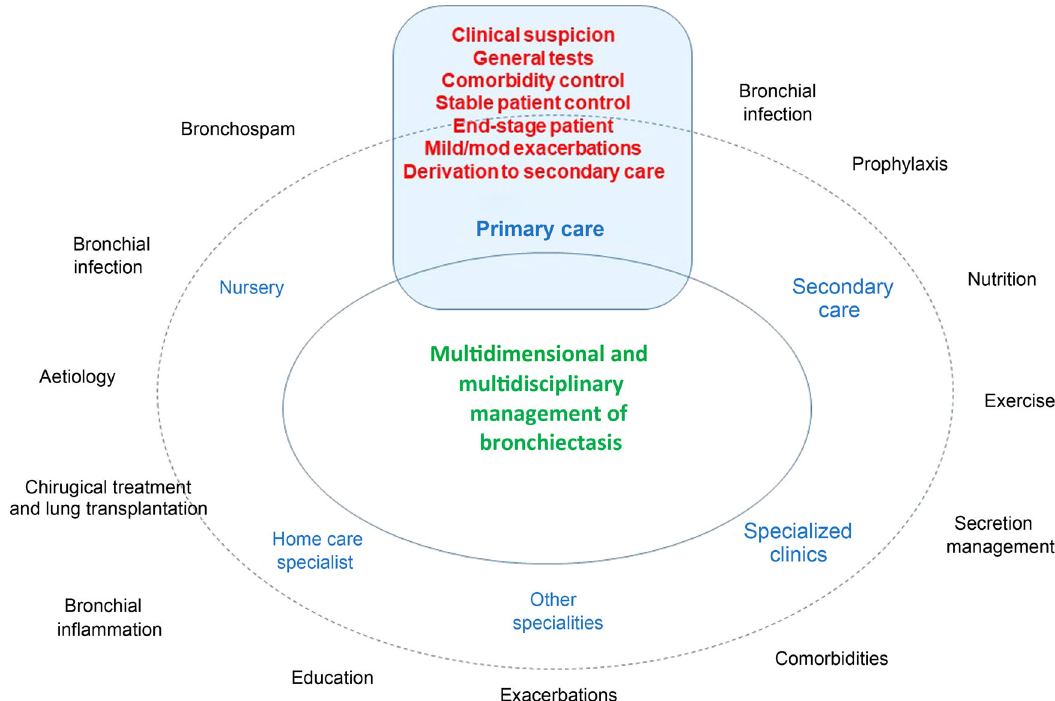
Fig. 3 Multidimensional and multidisciplinary management of bronchiectasis. Role of Primary Care. Bronchiectasis is a disease that is both multidimensional (since it is necessary to treat all its therapeutic aspects or treatable traits) and multidisciplinary (since various specialities must monitor these patients). Within this multidisciplinarity, the role of Primary Care is absolutely essential in many aspects such as clinical suspicion, the performance of diagnostic or aetiological tests, monitoring of stable patients, collaboration with secondary/tertiary care in complex patients, management of end-stage patients, management of exacerbations and comorbidities and referral of the patient to secondary/tertiary centres, when